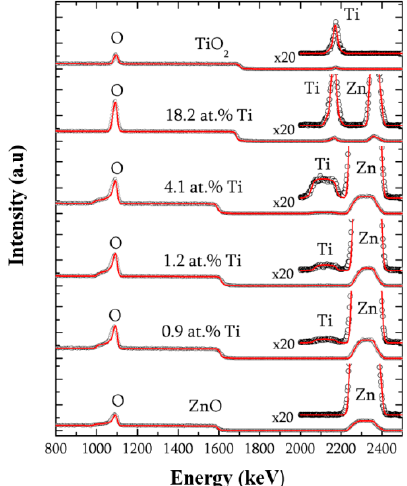
Figure 1. The Rutherford backscattering spectroscopy (RBS) spectra (experimental and simulated) of ZnO films with an increasing Ti content (from below to above): A zoom (×20) is included for the high energy region to magnify the signal of Zn and Ti.